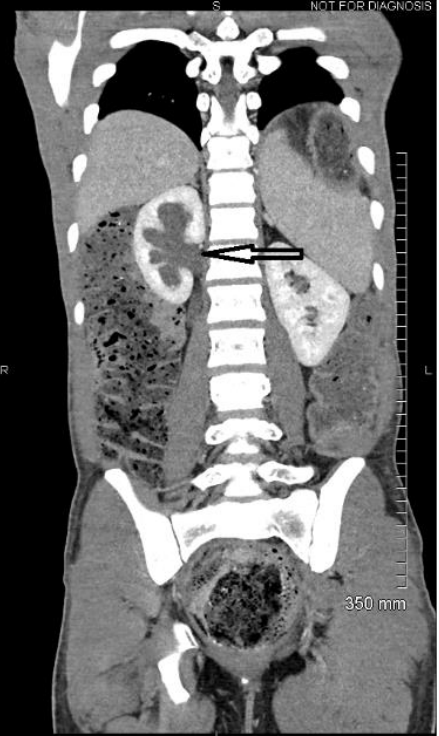
Image 1. Coronal section of the abdomen by computed tomography displaying extent of the extensive stool burden.